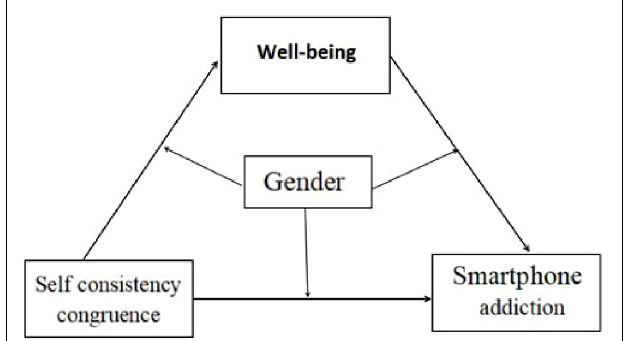
FIGURE 1 | Intermediary model with